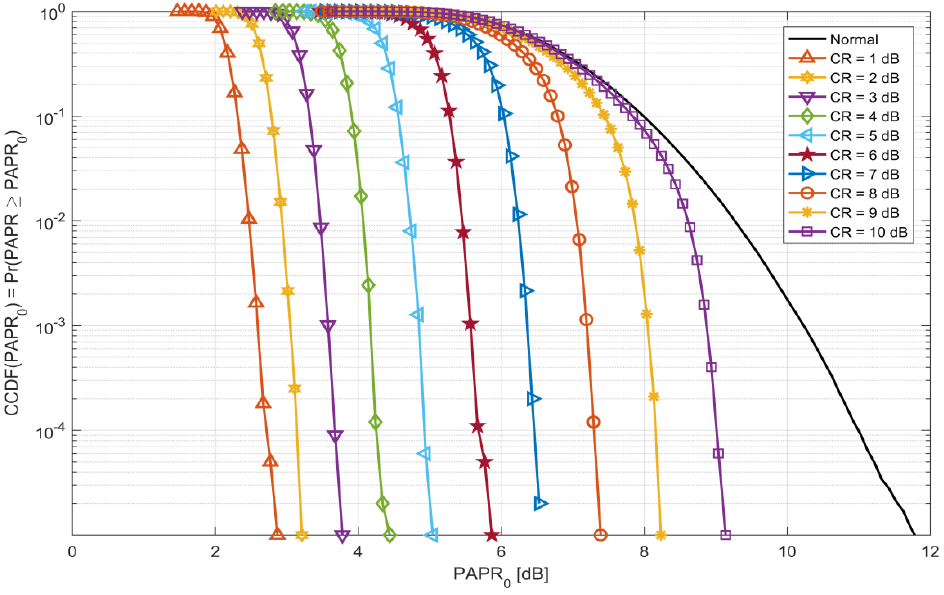
Figure 13. CCDF of PC-OFDM with 16-QAM for different Clipping Ratios.